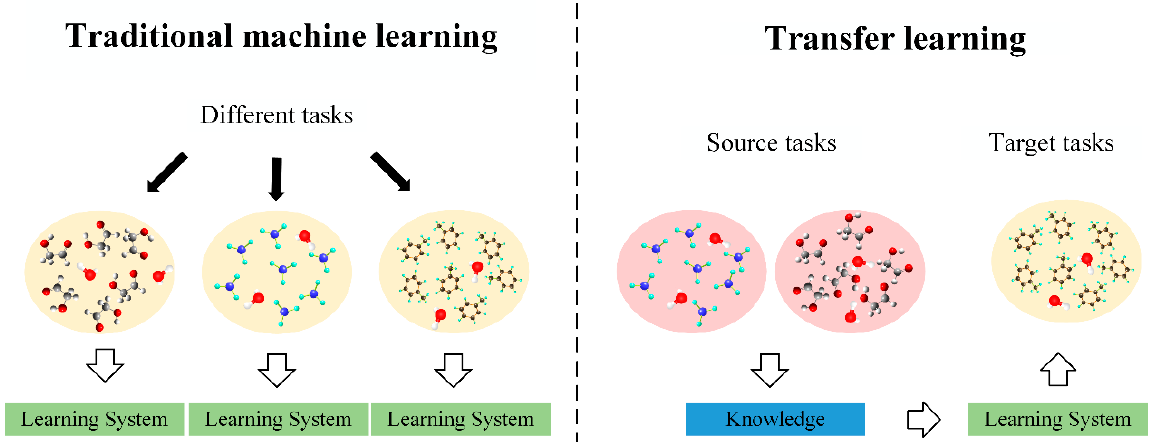
Figure 1. The differences between the transfer learning approach and the traditional machine learning approach. Transfer learning can also be expressed more accurately by domains and